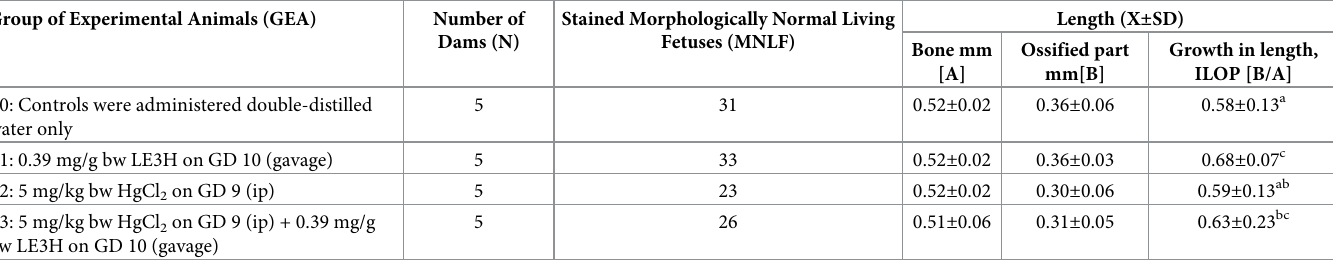
Table 3. Length of humerus bone of M . musculus fetuses on Gestation Day (GD) 18 which previously were given 0.39 mg/g bw LE3H through gavage on GD 10 (E1), injected with 5 mg/kg bw HgCl Group of Experimental Animals (GEA) Number of